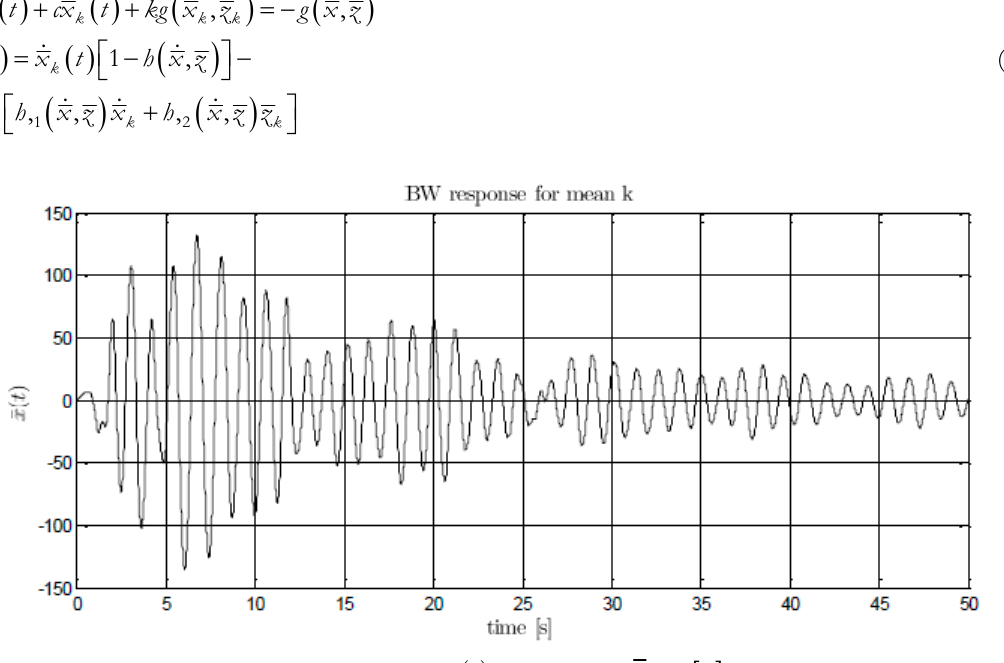
Figure 9: Response   x t evaluated for    k E k .